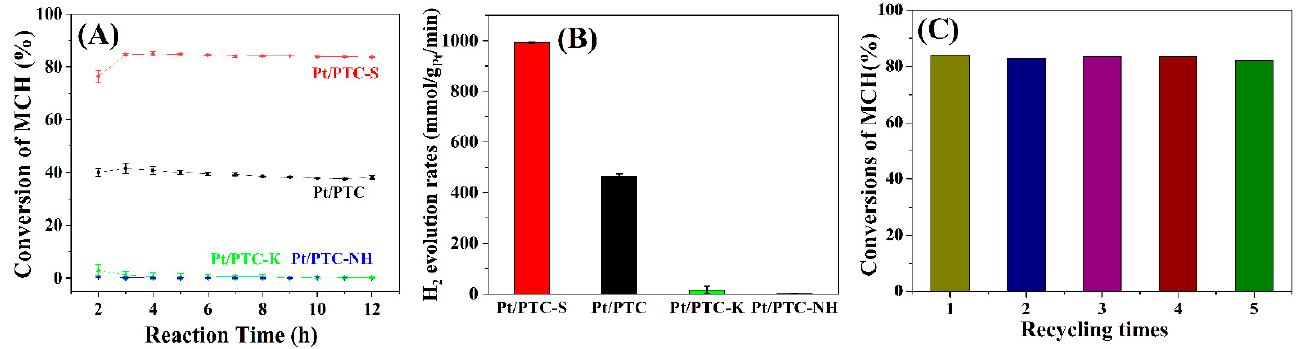
Figure 6. ( A )The conversions of MCH dehydrogenated into toluene by Pt-based catalysts; ( B ) the hydrogen evolution rates of the Pt-based catalysts; ( C ) recycling study of Pt/PTC-S. Table 3. Comparison of dehydrogenation of MCH and hydrogen production with other Pt catalysts reported in the literature at 300 °C.